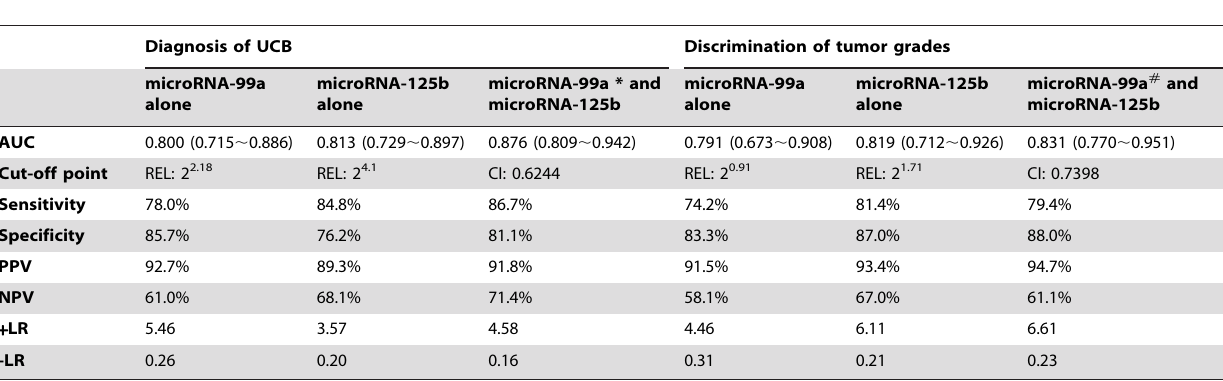
Table 2. Diagnostic strength of microRNA-99a alone, microRNA-125b alone and microRNA-99a and microRNA-125b in combination for the detection of bladder cancer and their significance in discriminating tumor